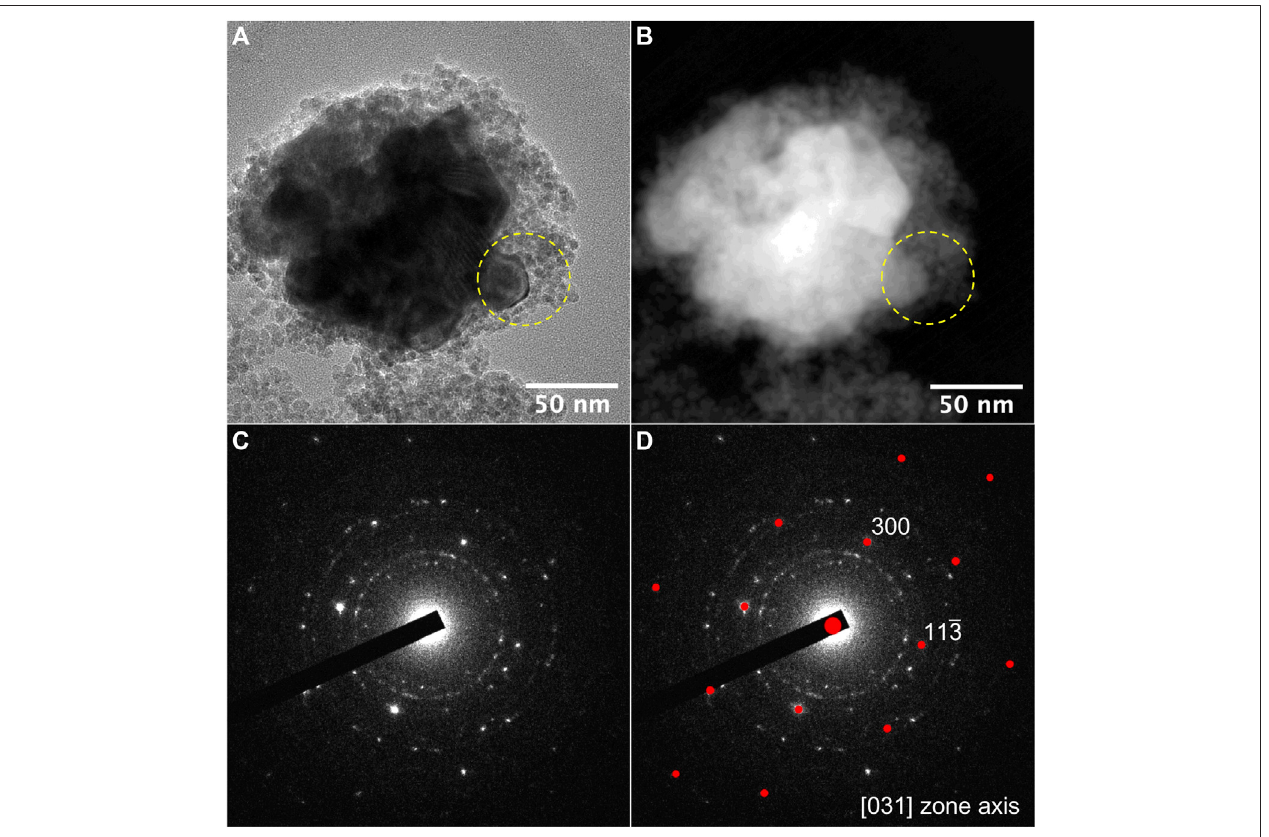
FIGURE3|(A) TEM-BFand (B) STEM-HAADFimagesofanaggregateofferriteandNi 3 Cnanoparticles; (C) SAEDrelatedtotheareade fi nedbytheyellowdashed circle. Ni 3 C single crystal diffraction pattern is superimposed to the ring diffraction pattern due to ferrite NPs; (D) calculated diffraction pattern of Ni 3 C along [031] zone axis.